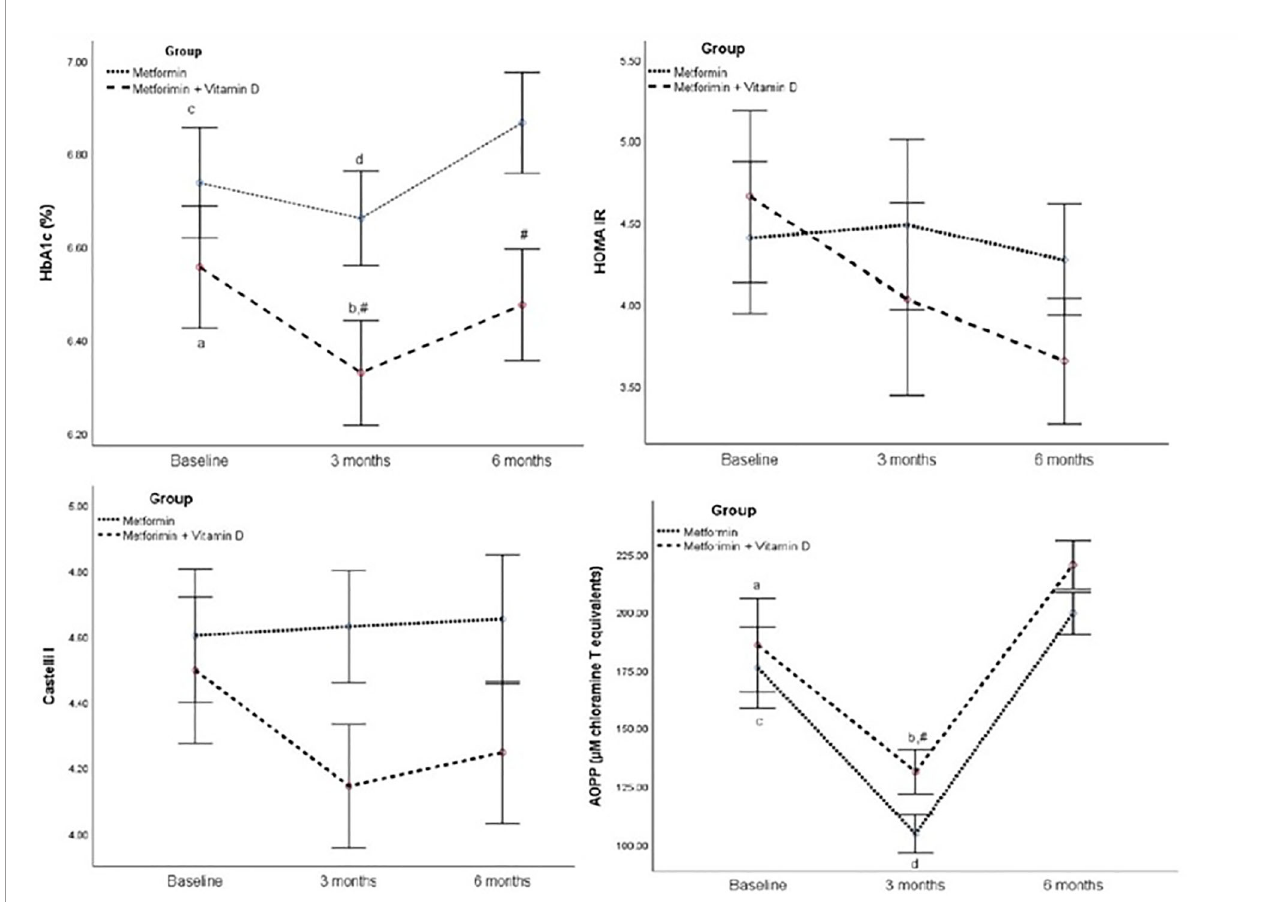
FIGURE 2 | HbA1c, HOMA IR, Castelli I, and AOPP in the follow-up of 6 months between Metformin and Metformin + Vitamin D group. Data are presented mean ± SE, In two way ANOVA for repeated measures: In the Metformin + Vitamin D group: p<0.05 a vs 3 months, b vs 6 months, In the Metformin: p<0.05 c vs 3 months, d vs 6 months, # between group at speci fi c time